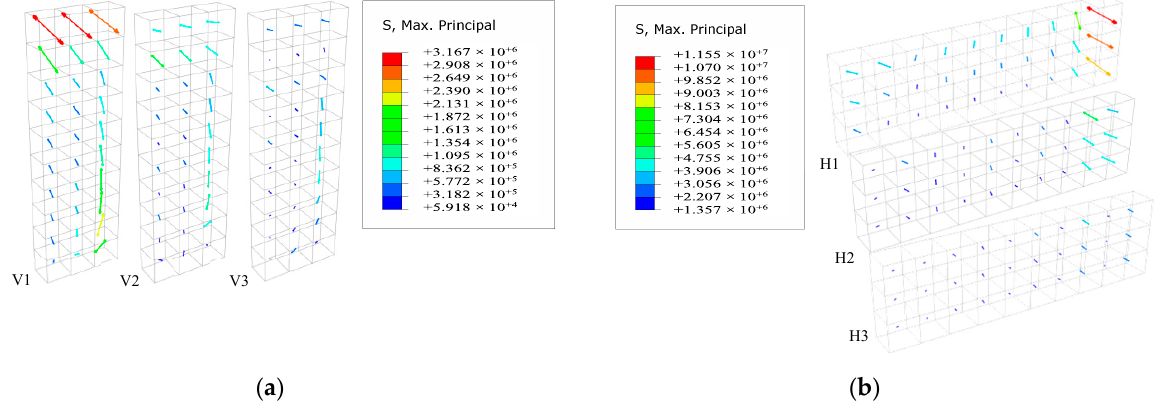
Figure 22. Tensile stress vector diagram of the shear key: ( a ) shear key B; ( b ) shear key E. (unit: Pa).